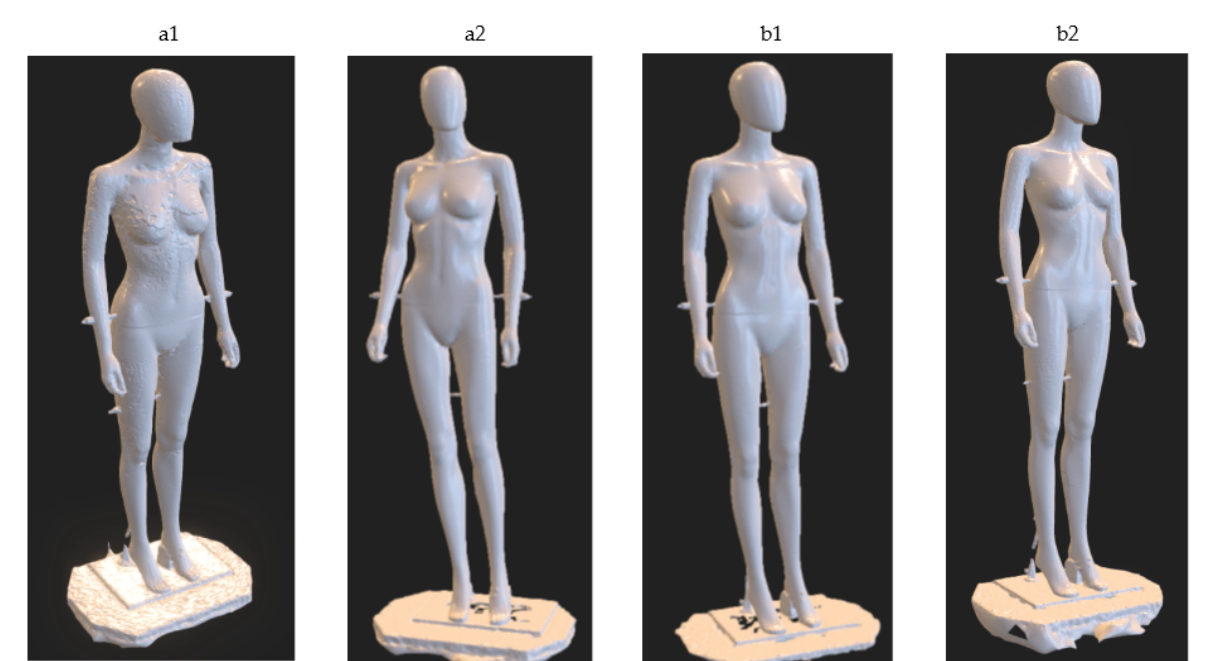
Figure 10. The results of the experimental tests of the HUBO scanner for particular variants—3D models in the form of a triangle meshes obtained for variants a1, a2, b1 and b2.